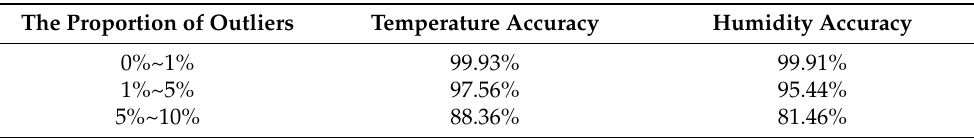
Table 2. The average value of outlier detection results for three different scales, each scale carried out 3000 experiments. The Proportion of